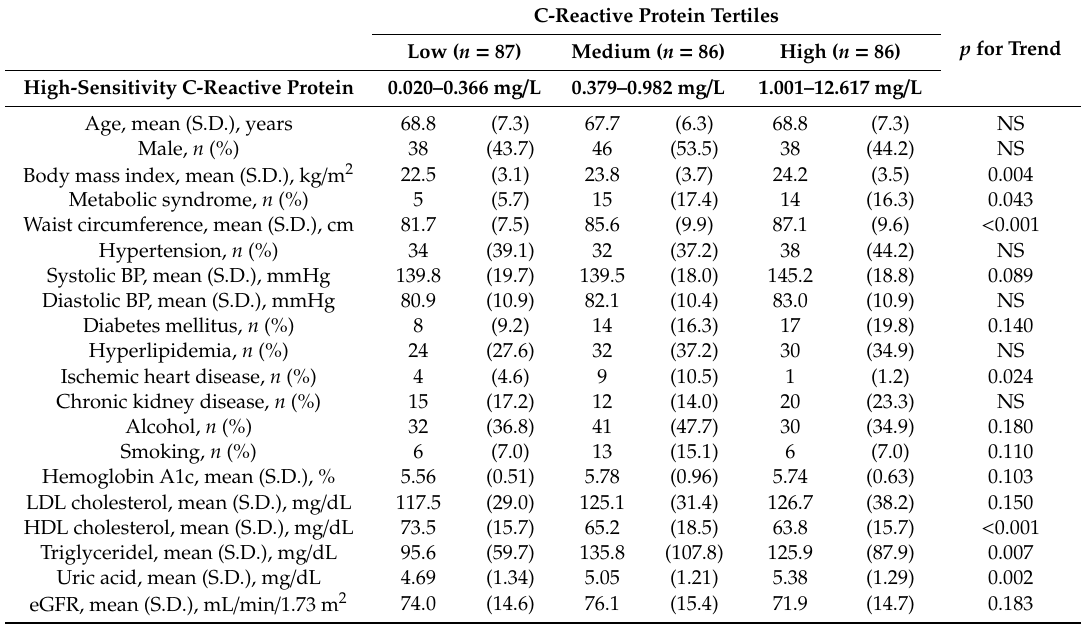
Table 1. Characteristics of the Study